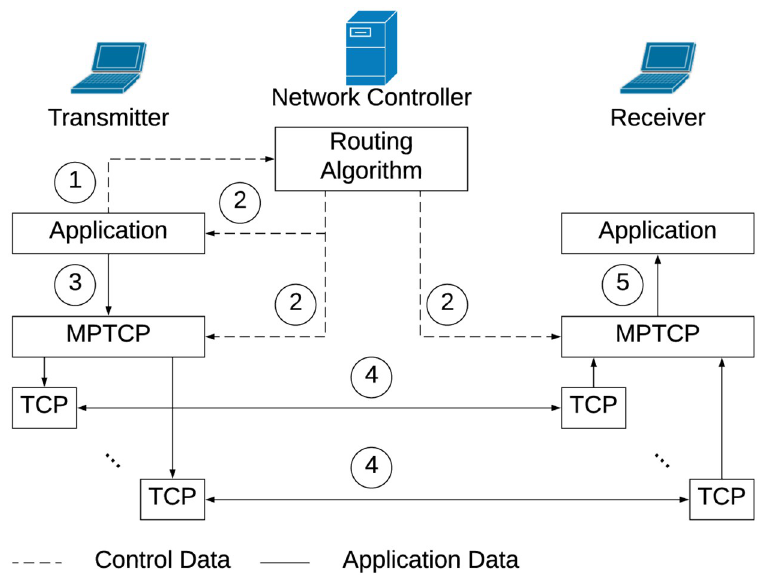
Fig 2. The proposed MPTCP framework. The numbers represent the sequence of events, in order, when an application has data to transmit [27].